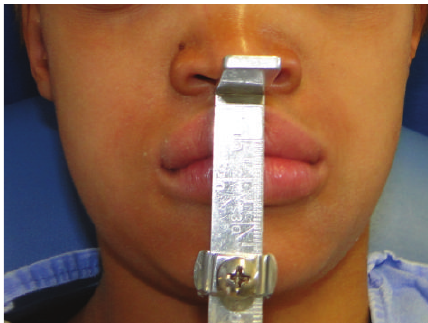
Figure 6: Initial frontal view of the patient. Note the diminished OVD.